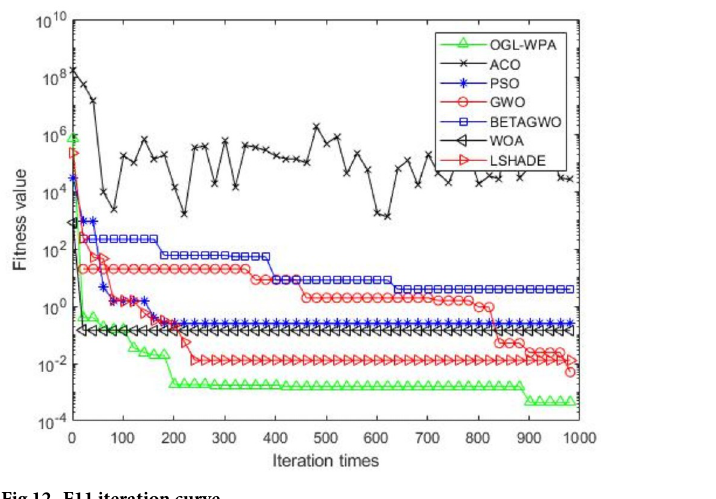
Fig 12. F11 iteration curve.